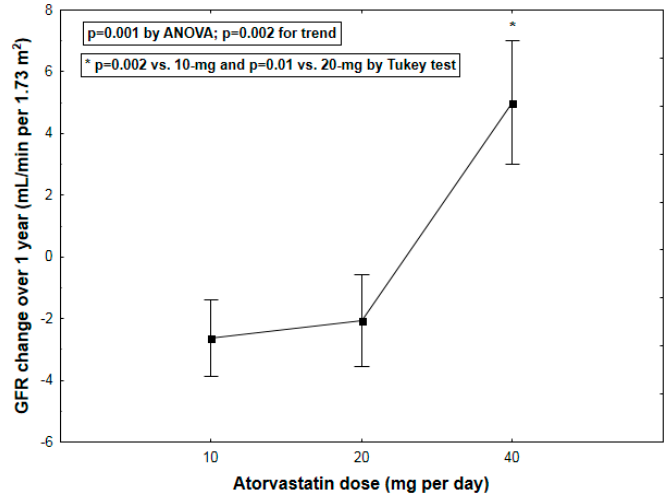
Figure 1. Changes of glomerular filtration rate (GFR) over 1 year (mean ± SEM) according to atorvastatin dosage.